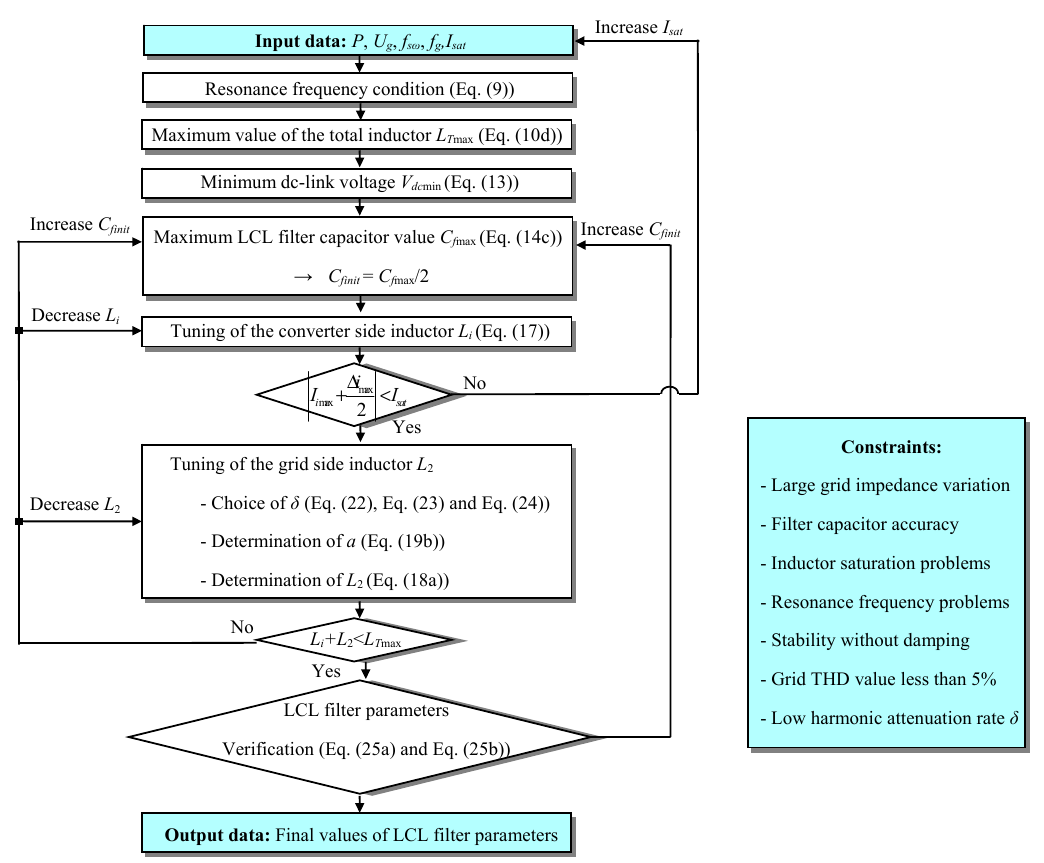
Figure 5. LCL filter design algorithm.